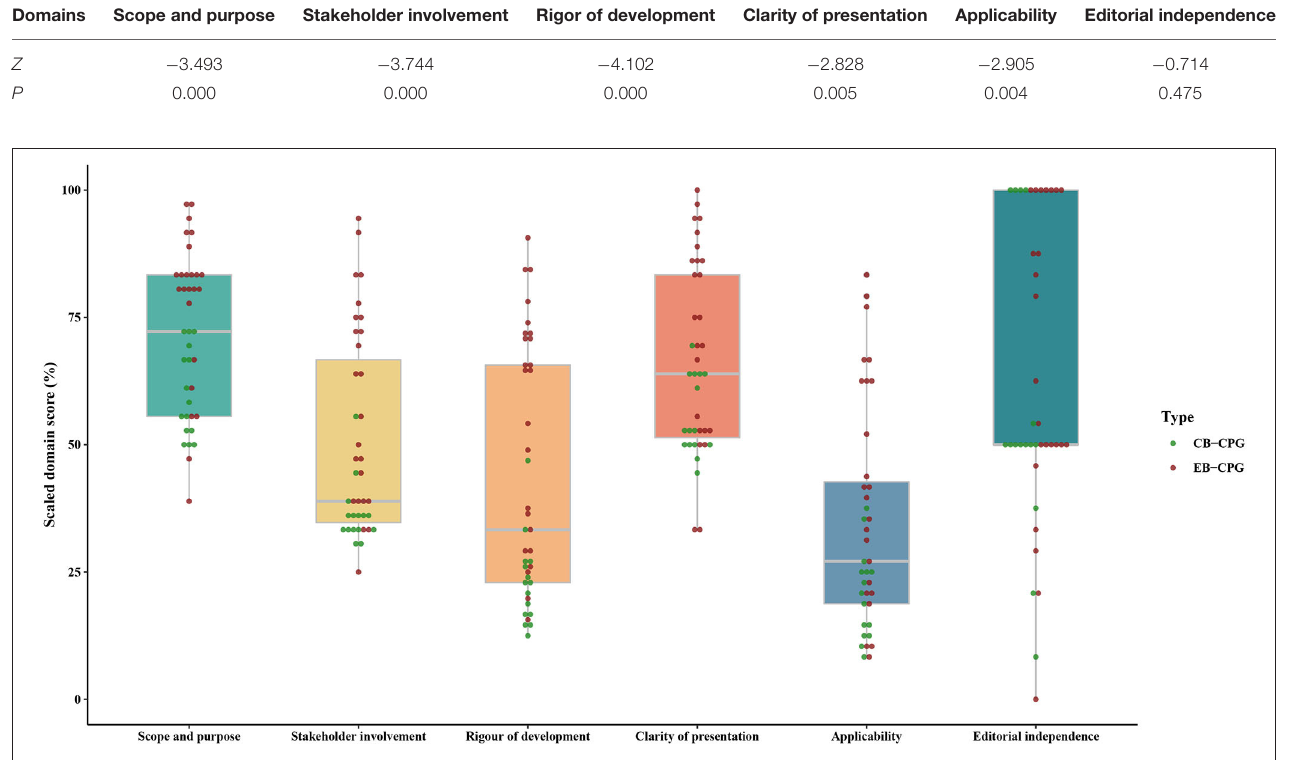
TABLE 1 | The difference of quality between EB-CPGs and CB-CPGs.